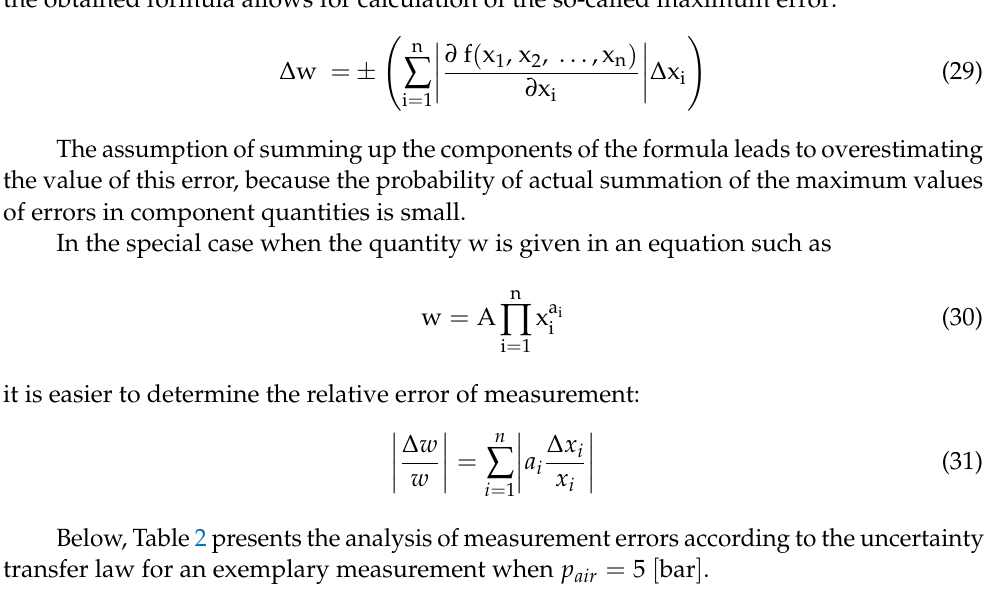
Table 2. Analysis of measurement errors according to the uncertainty transfer law (example for p air = 5 [ bar ]